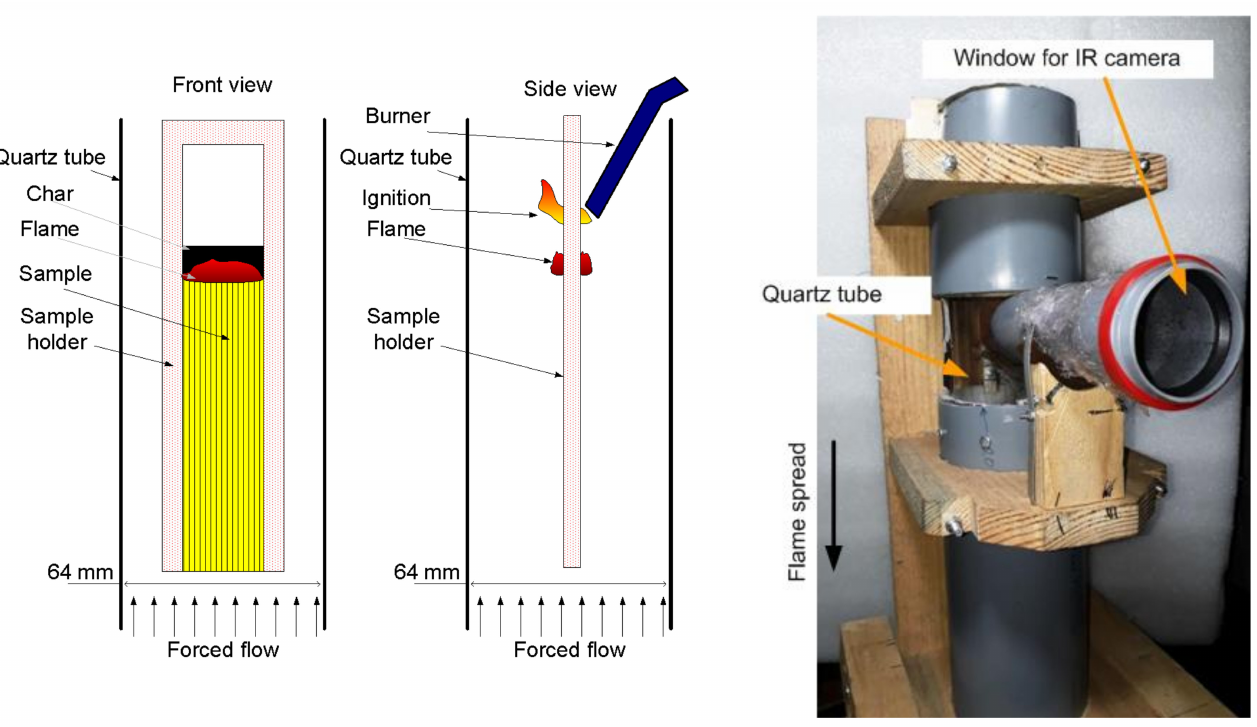
Figure 1. The schematic of the experimental setup (front view—( left ), side view—( center )) and its photo ( right